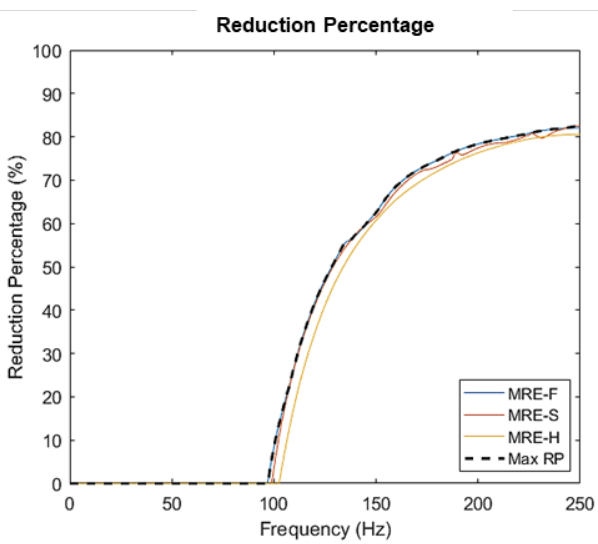
Figure 15. The reduction percentage curve for MRE-F, MRE-S, and MRE-H. Table 5. The damping coefficients of MRE-F, MRE-S, and MRE-H at different current values. Applied Current